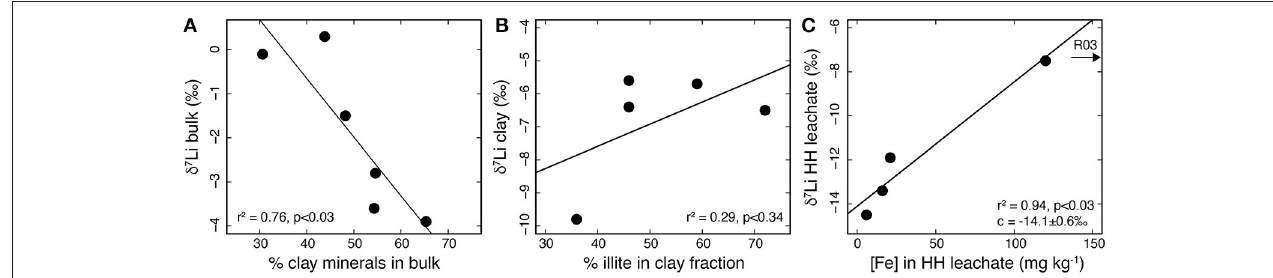
FIGURE 6 | (A) Plot of δ 7 Li bulk vs. the relative proportion of clay minerals in the bulk sample. The proportion of clay minerals was calculated by summing the relative abundances of chlorite, illite/mica, kaolinite and illite/smectite obtained by XRD (Hindshaw et al., 2016a). Higher relative clay mineral abundances are associated with lower δ 7 Li values. (B) Plot of δ 7 Li clay vs. the relative proportion of illite in the clay-sized separate ( < 2 µ m). There is no relationship between the relative abundance of illite and δ 7 Li. (C) Plot of δ 7 Li vs. Fe concentrations in the HH leachate. The more Fe (assumed to be a proxy for Fe-Mn oxyhydroxide content), the higher the δ 7 Li value, and presumably a greater fraction of Li removed from solution. Sample R03, which contained 1707 mg kg − 1 Fe, was not included in the line fitting. This sample likely has other iron sources in addition to Fe-Mn oxyhydroxides (Hindshaw et al.,